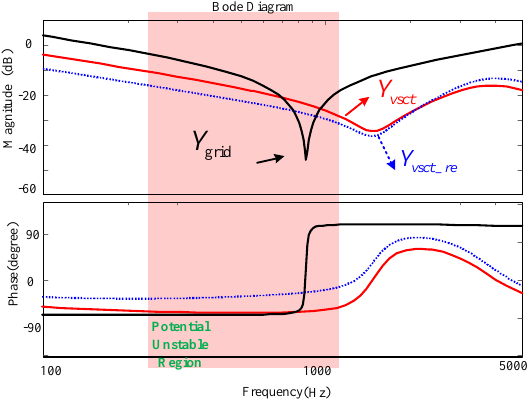
Figure 13. Bode diagram of integral system.